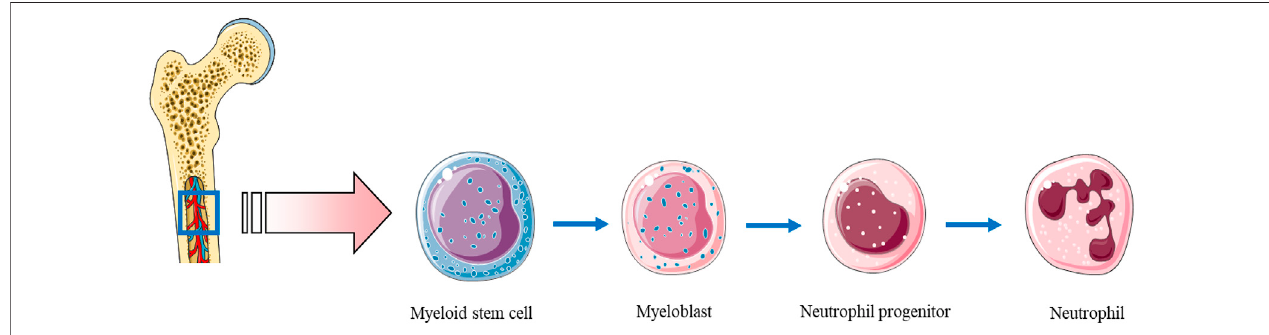
FIGURE 1 | The granulocyte